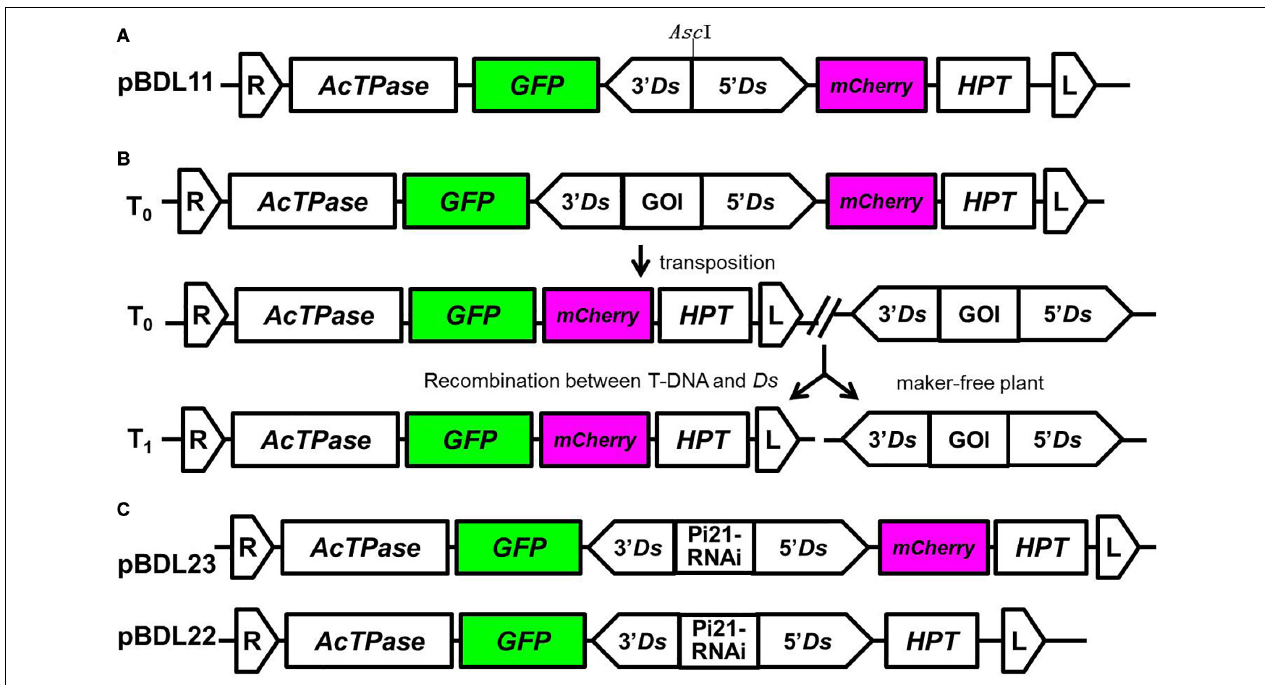
FIGURE 1 | Double-fluorescent protein-expressing Ac/Ds transposon vectors for the generation of marker-free transgenic plants. (A) pBDL11 is a double-fluorescent protein-expressing Ac / Ds universal vector for transgene reintegration. pLJ26 (Gao et al., 2015) is a single-fluorescent protein-expressing Ac / Ds universal vector used to compare the efficacy of screening transgenic progeny with pBDL11. The Asc I restriction sites in pBDL11 and pLJ26 were used for insertion of the gene of interest (GOI). (B) A diagram of Ds transposition-mediated transgene reintegration. The working pattern of the double fluorescent protein-expressing Ac/Ds vector is as follows: (i) T-DNA is integrated into the plant genome during transformation; (ii) by the action of Ac TPase, Ds is excised from T-DNA and reintegrated at another site in the plant genome; (iii) T1 progeny carrying reintegrated Ds elements, from which T-DNA sequences including HPT and Ac TPase are removed, are generated by genetic recombination. (C) The Ac / Ds vectors pBDL23 and pBDL22, in which Ds elements harbor an RNAi cassette of the rice gene Pi21 conferring rice blast disease resistance, were constructed to generate marker-free disease-resistant transgenic rice